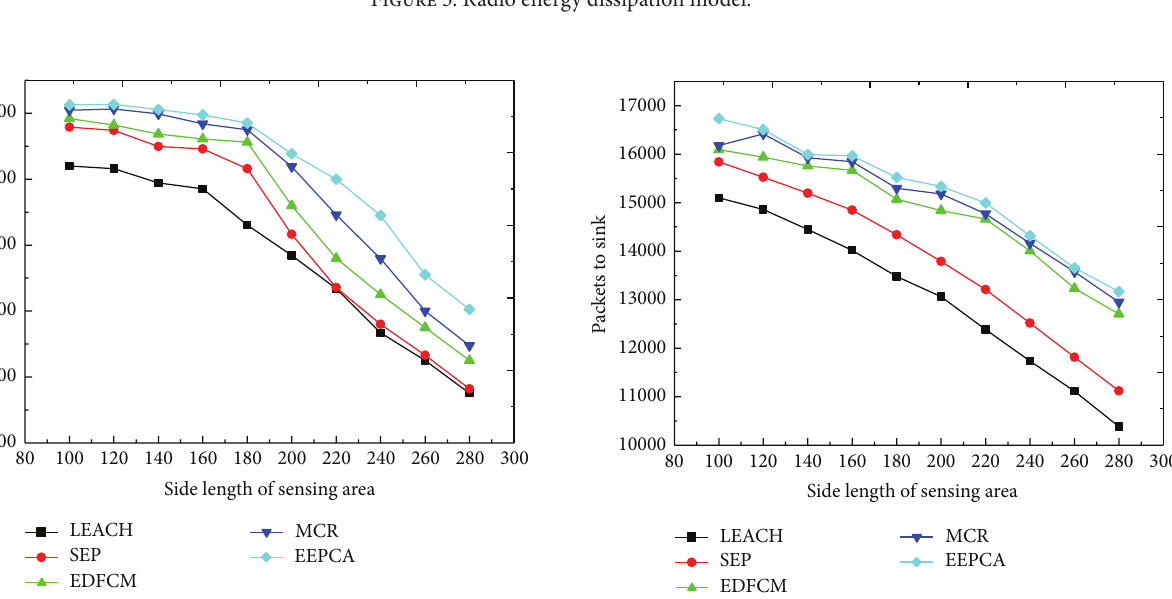
Figure 4: Round of first node dies with varying side length of sensing area.